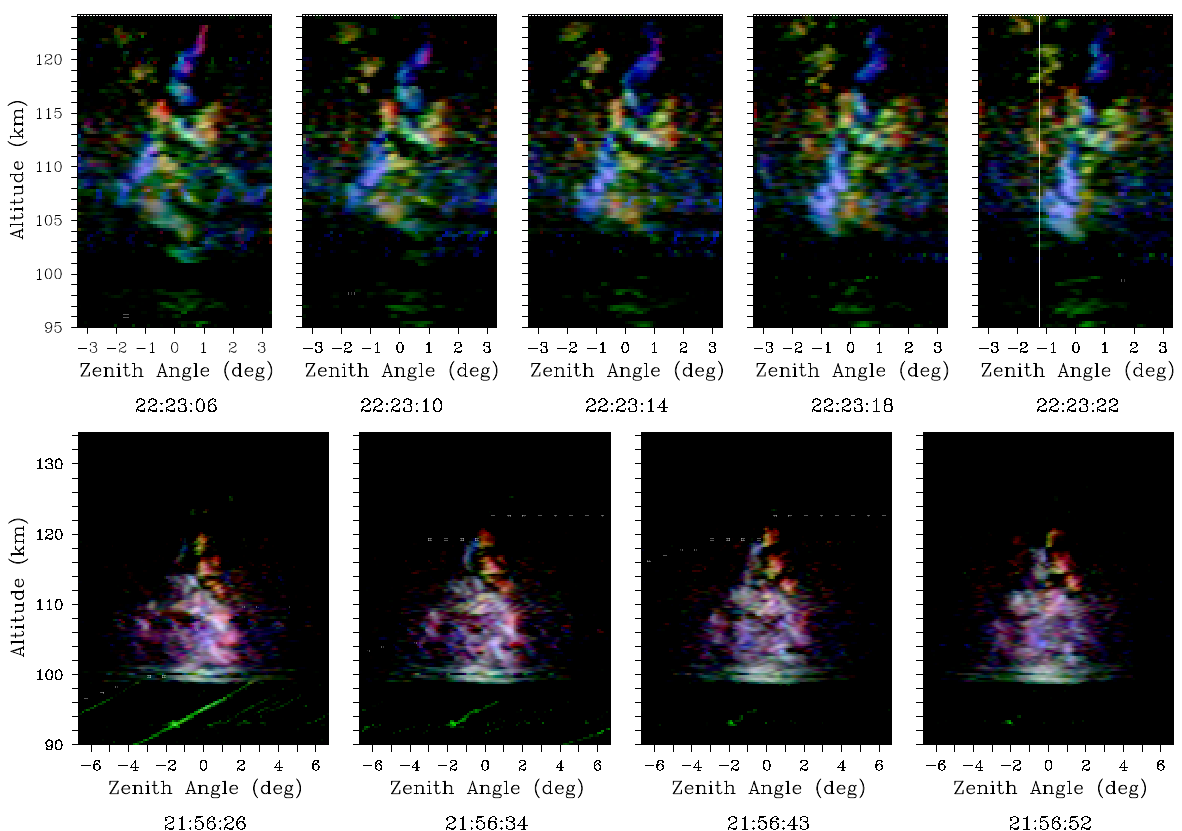
Fig. 3. Radar images of nighttime electrojet waves observed on 24 April 2000. Note the range-spread meteor evident in the images on the bottom row of the